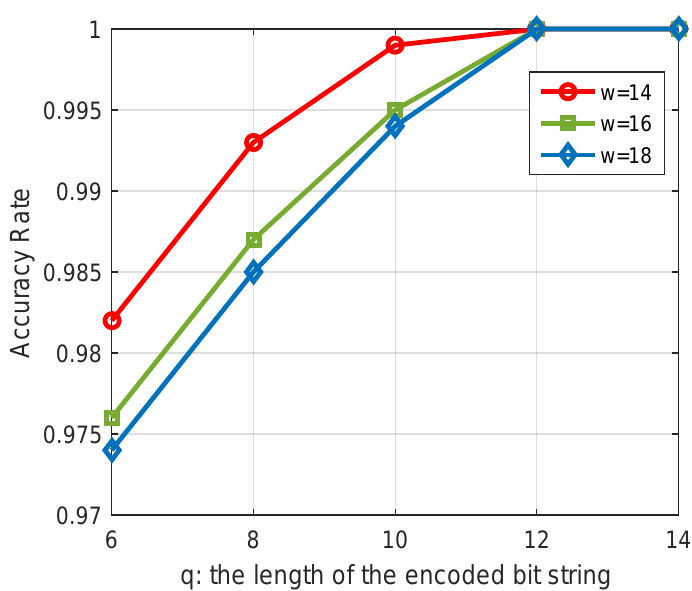
Figure 5. Accuracy rate of estimated data influenced by the value of q , where n =